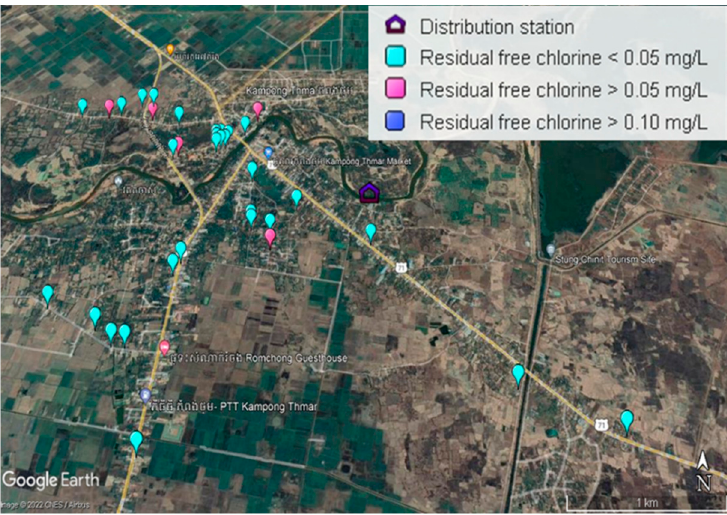
Figure 2. Field monitoring of residual chlorine in NN.